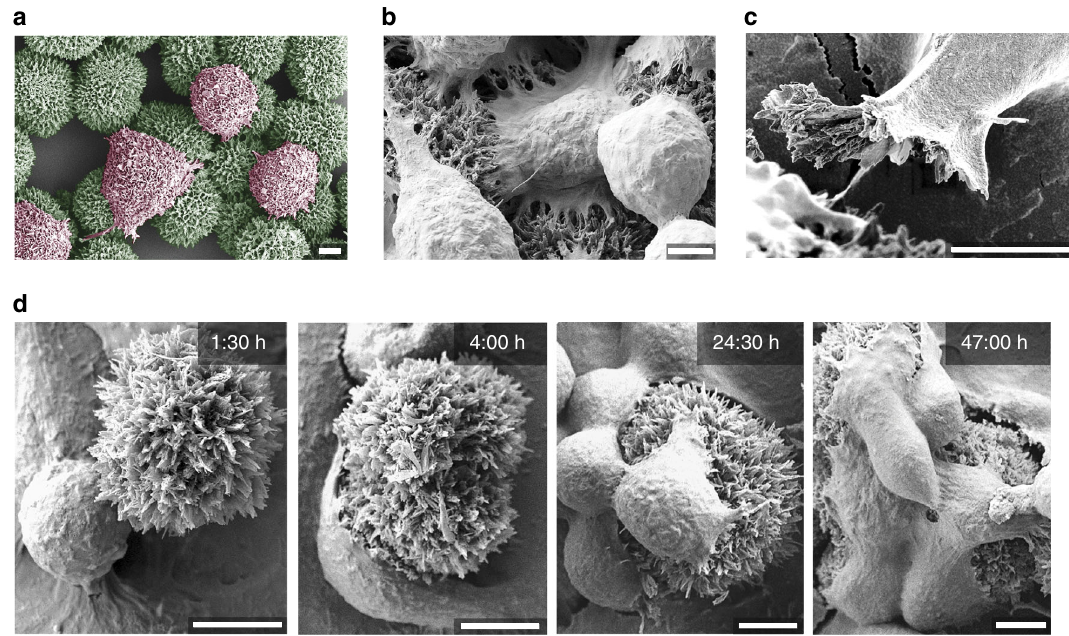
Fig. 4 SEM imaging of rat basophilic (RBL) cells cultured with quinacridone nanohedgehogs. a RBL cells cultured on 10- µ m-size nanoneedle hedgehogs, with cells false-coloured pink and hedgehogs false-coloured green . The image captures the cells when they are degranulating. b Tight interfaces between RBL cells and nanoneedle hedgehogs. c The cell membrane and extracellular matrix of RBL cells can rip nanoneedles out of the hierarchical microcrystal, demonstrating the strength of the cell/nanocrystals interaction. d RBL cell culture interrupted at different intervals (hours shown in image upper right corners ), showing the progression of cell attachment, proliferation and morphology over time. Scale bars = 5 µ